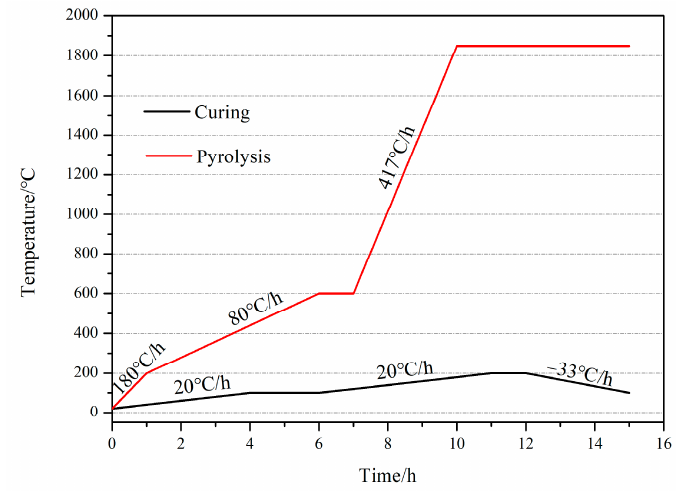
Figure 2. Process program for curing and pyrolysis.